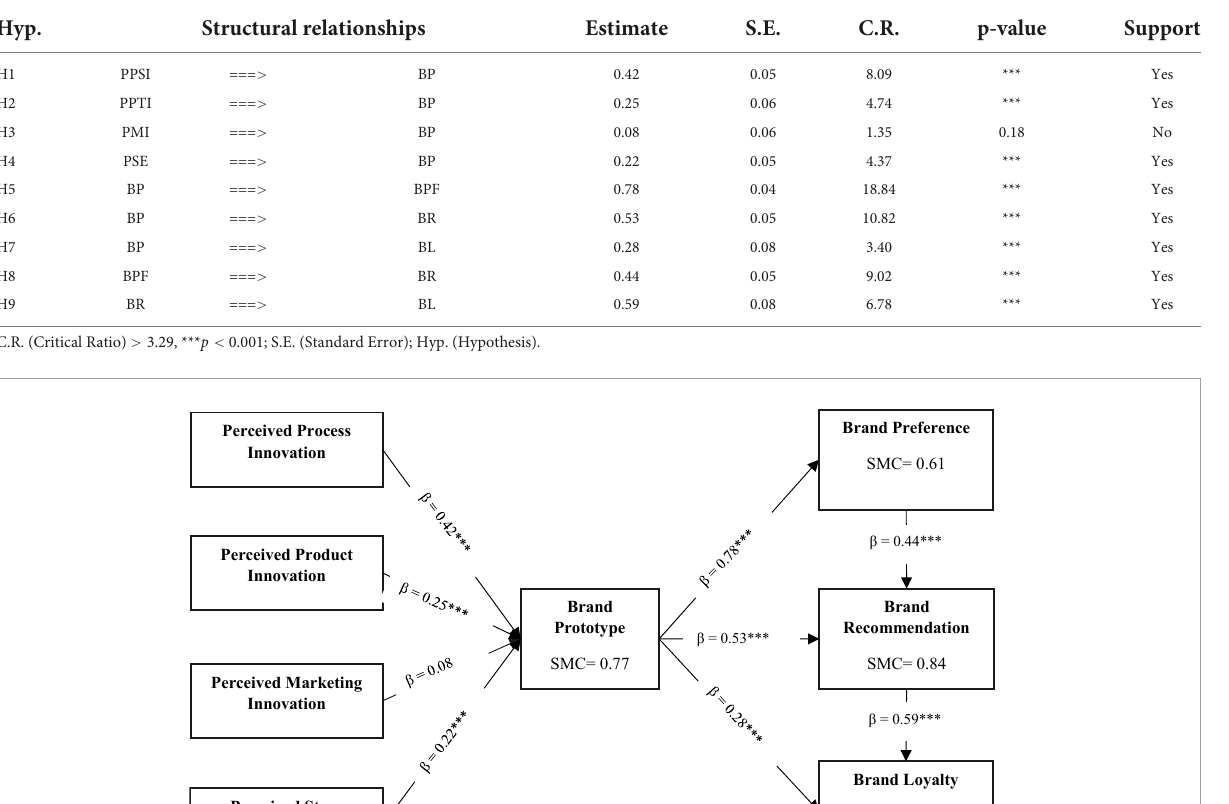
TABLE 5 Hypotheses testing.